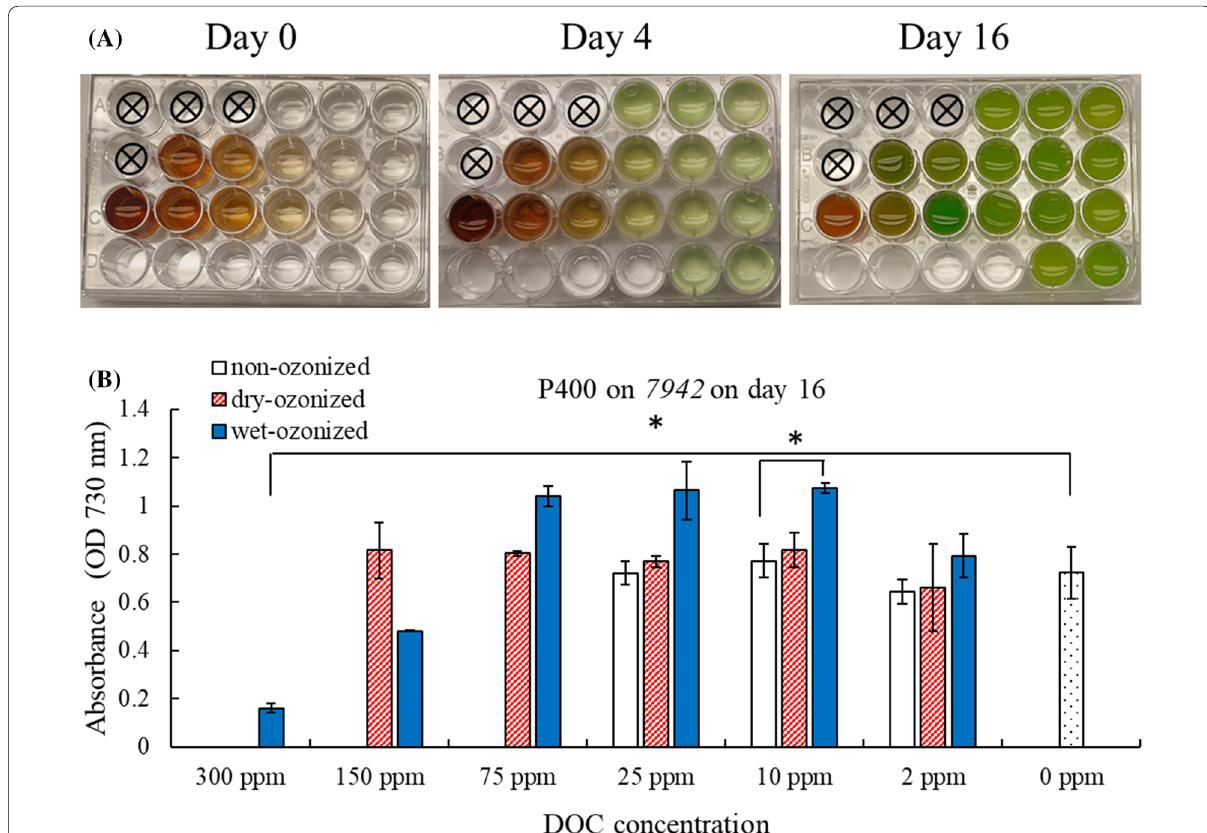
Fig. 4 Growth assay of Synechococcus elongatus PCC 7942 (7942) in incubation with filtrates from wet-ozonized, dry-ozonized, and non-ozonized pine 400 (P400) biochar at different DOC concentrations. A Photographs of multi-well plate with P400 biochar filtrates inoculated with 7942 on day 0, day 4 and day 16 of the growth assay. The photographs shown are one of the two replicates. The setup of the plate is shown in Table 1. B Optical density (OD730) of 7942 after 16 days of incubation with P400 biochar filtrates. The error bars on the graph represent the standard deviation of the 2 multi-well plates ( n 2). The asterisks brackets (*) show significant difference ( p < 0.05) between =